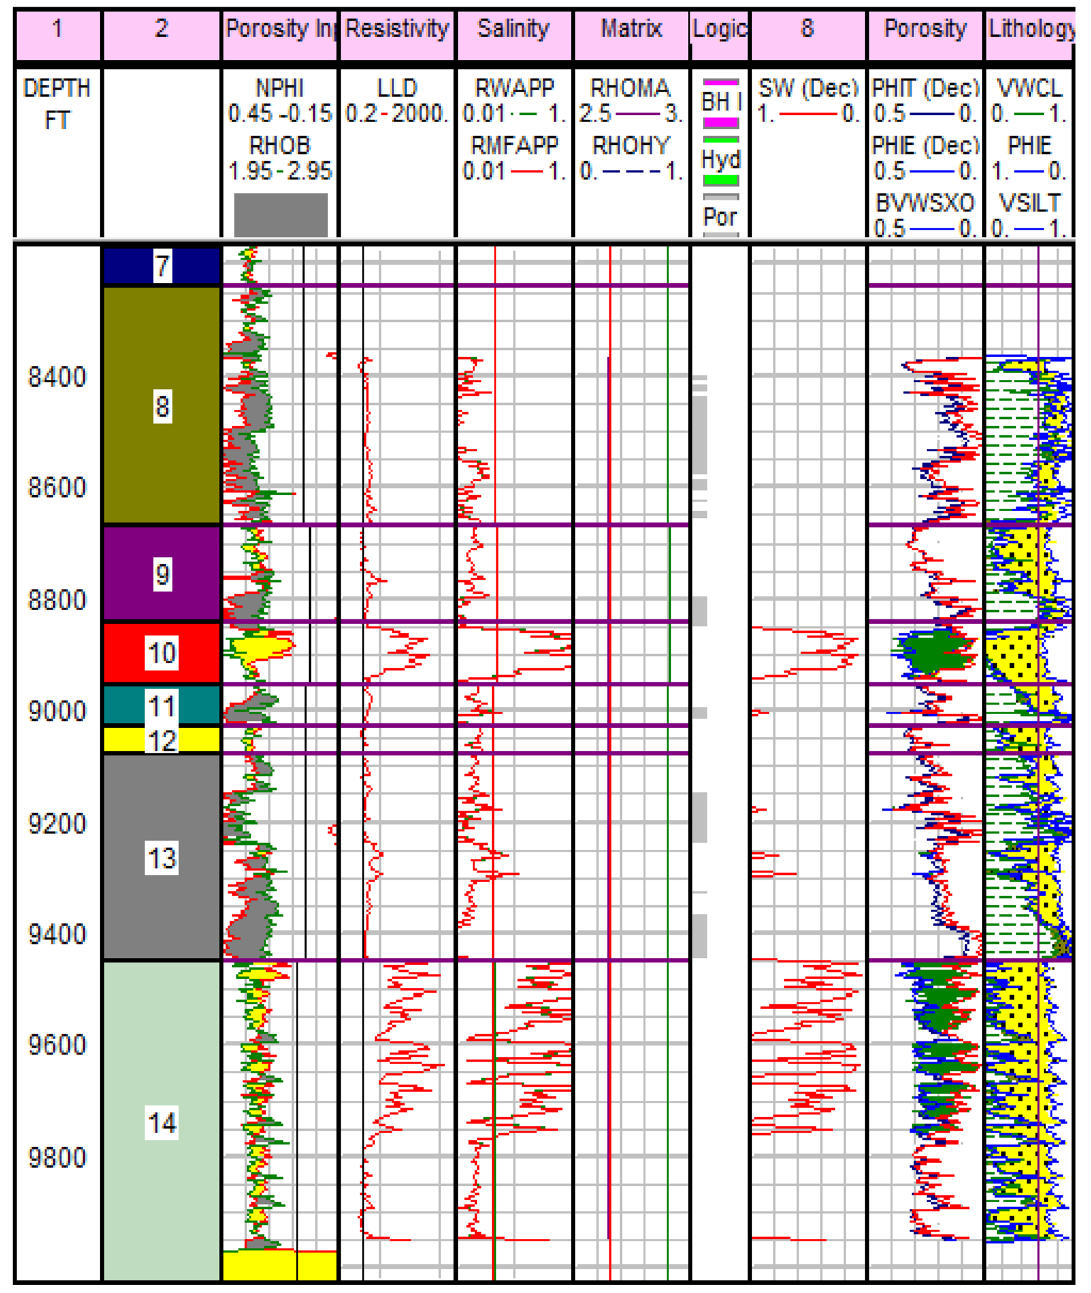
Fig. 8 Estimated porosity, water saturation and fluid types present in JAP-3